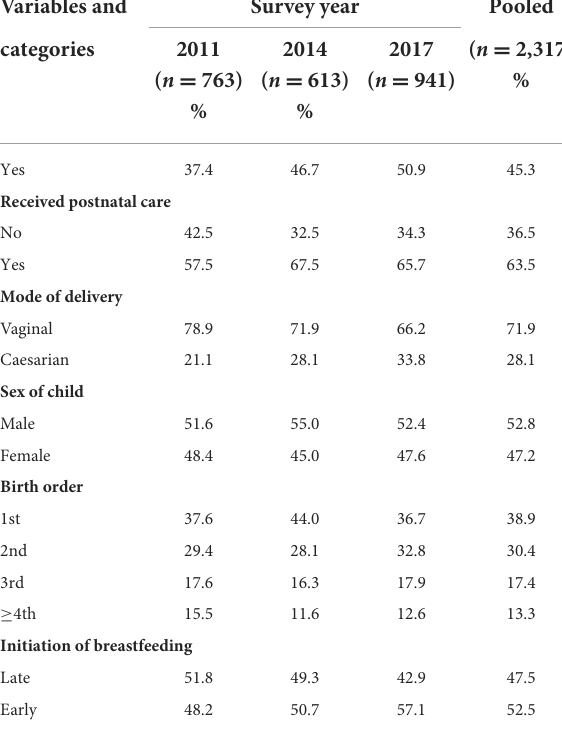
TABLE 1 Percentage distributions of the demographic, socio-economic, and health-related characteristics of the respondents in different survey years as well as for pooled